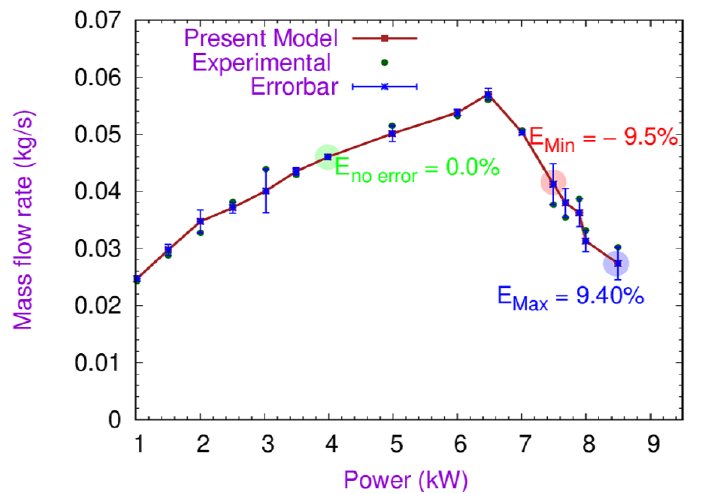
Figure 2. Validation of the present model with experimental results.